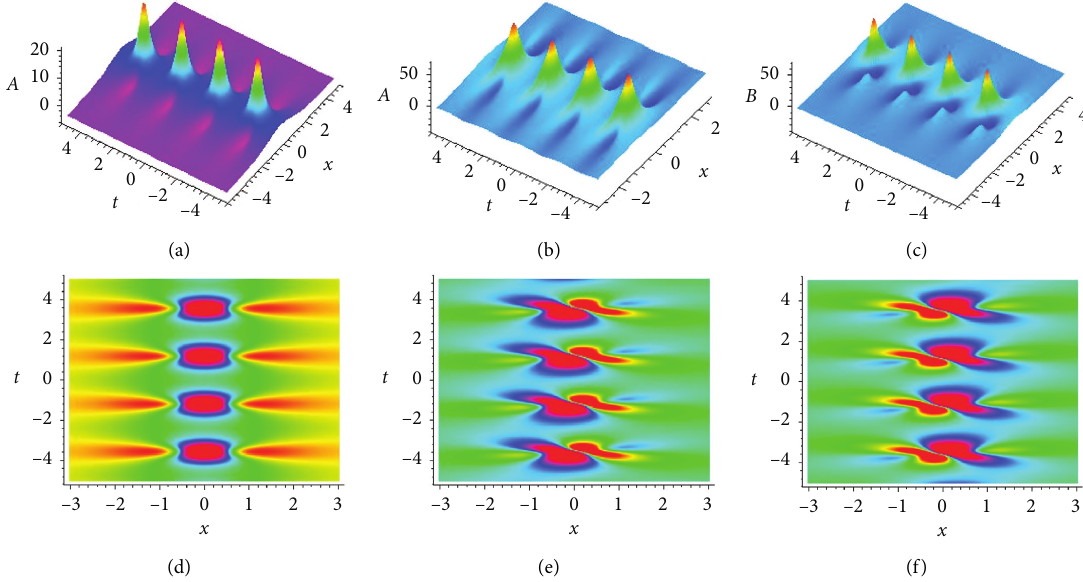
Figure 3: The t -breather solution of equation (23) with (a) b (a)–(c), respectively.